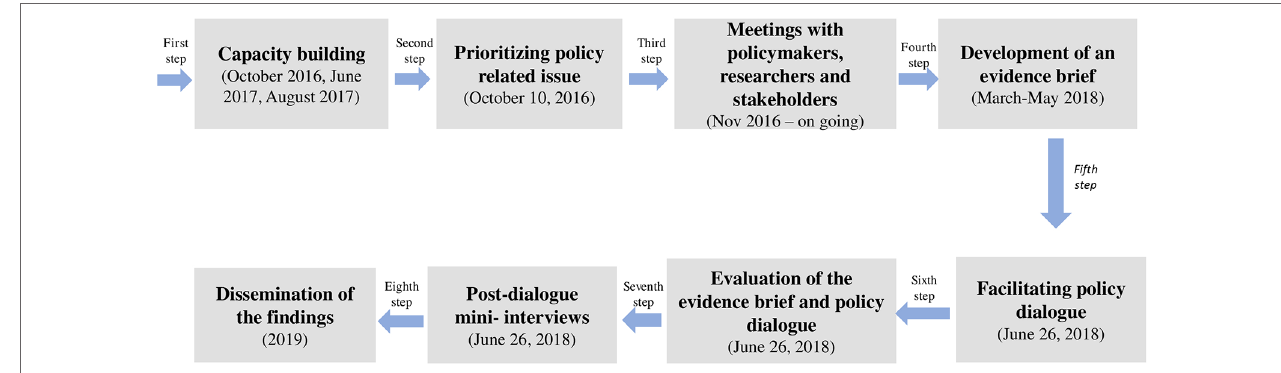
FIGURe 1 | Eight steps used on KT*. *Adapted from Yehia; El Jardali (Yehia and El Jardali, 2015).